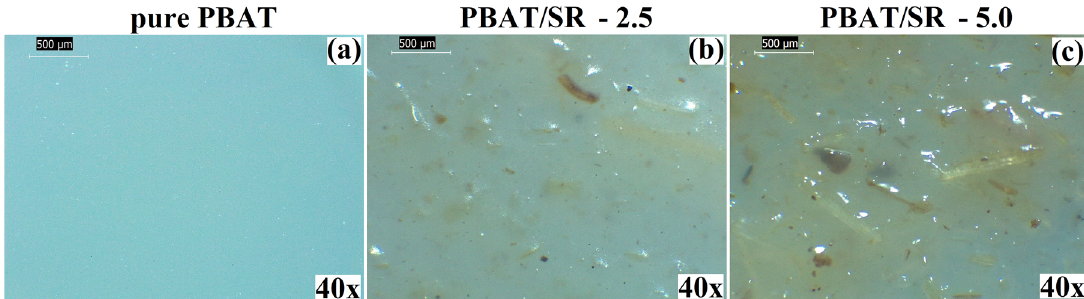
Figure 3. Optical microscopy of the surface: a) pure PBAT and PBAT/SR mulch films without carnauba wax: b) 2.5% SR and c) with 5.0% SR. (colored in the online version)